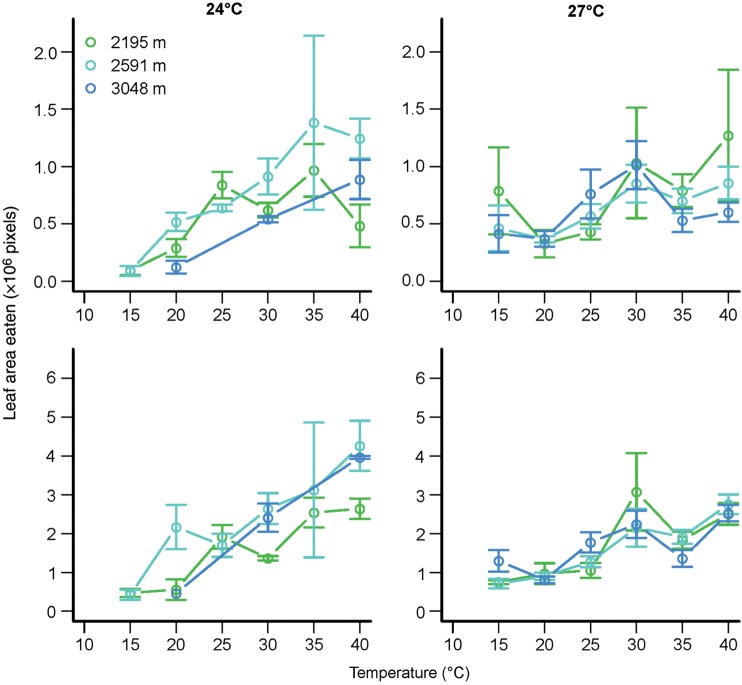
Grasshopper feeding rates (×106 pixels) over a 2 (top panels) or 8 h period (bottom panels) as a function of temperature (in degrees Celsius) for M. sanguinipes reared in the laboratory at 24 (left panels) and 27°C (right panels). Mean values ± SEM are depicted, with colours distinguishing sites.